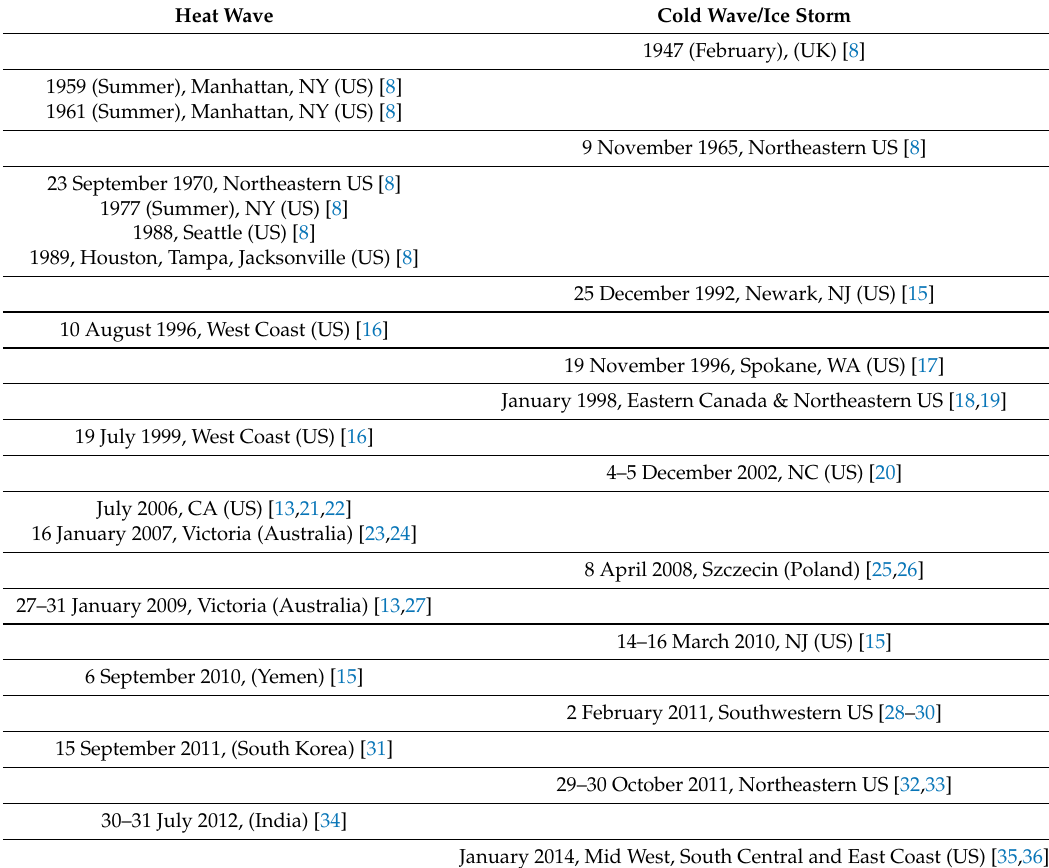
Table 1. Examples of historical power outages (blackouts, brownouts, etc.) caused by a heat or cold wave. Ice storms are included as they are usually associated to cold